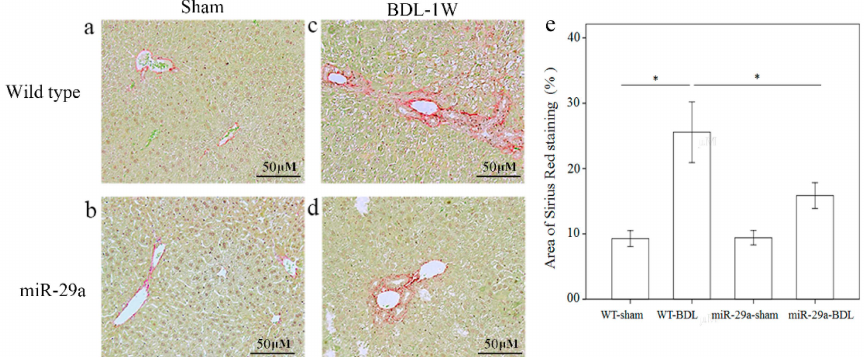
Figure 1. Overexpression of miR-29a in the murine model caused the downregulation of fibrosis in the mice livers following bile duct ligation. Sirius Red staining showed faint fibrosis in both sham operation of wide type ( a ) and miR-29a Tg mice ( b ) as well as moderate fibrosis in the –wild type mice ( c ) and mild fibrosis in the miR-29aTg mice ( d ), which was limited to the immediate vicinity of the portal area. ( e ) Data from the three samples per group are expressed as the mean ˘ SE. * indicates a p < 0.05 between the